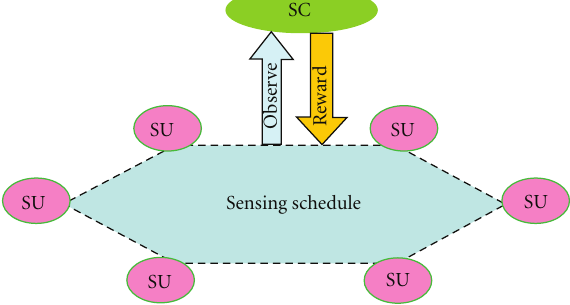
Figure 8: Replication dynamics.